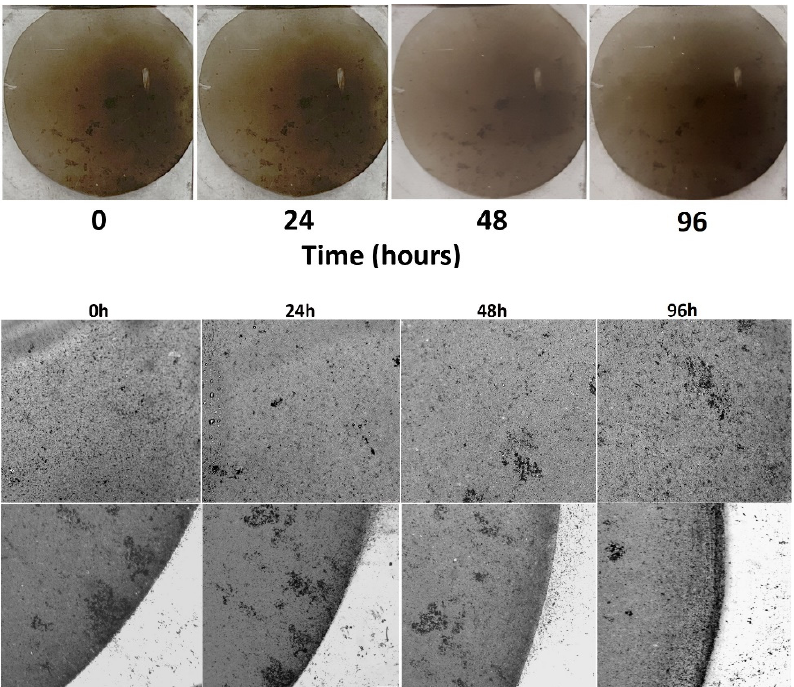
Figure 7. Representative digital photos of PDMS slices coated with GL-MAPLE and incubated in cell culture medium (DMEM) for 24–48 and 96 h at 37 °C with shacking. Images of GL-MAPLE films observed by phase–contrast light microscopy before and after the incubation. Images visualized with a 10×/0.40 (( upper ) panels) or 5×/0.30 (( lower ) panels) objectives, respectively. ( Lower ) panels highlight a particular of the edges of deposit.